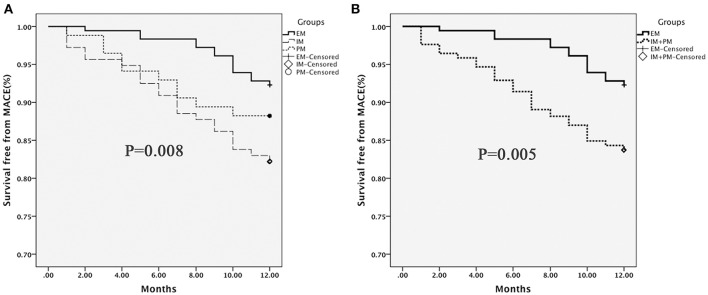
MACE-free survival in patients stratified by CYP2C19 metabolizer status. (A) EM vs. IM vs. PM; (B) EM vs. IM+PM. Differences were compared using the log-rank test.